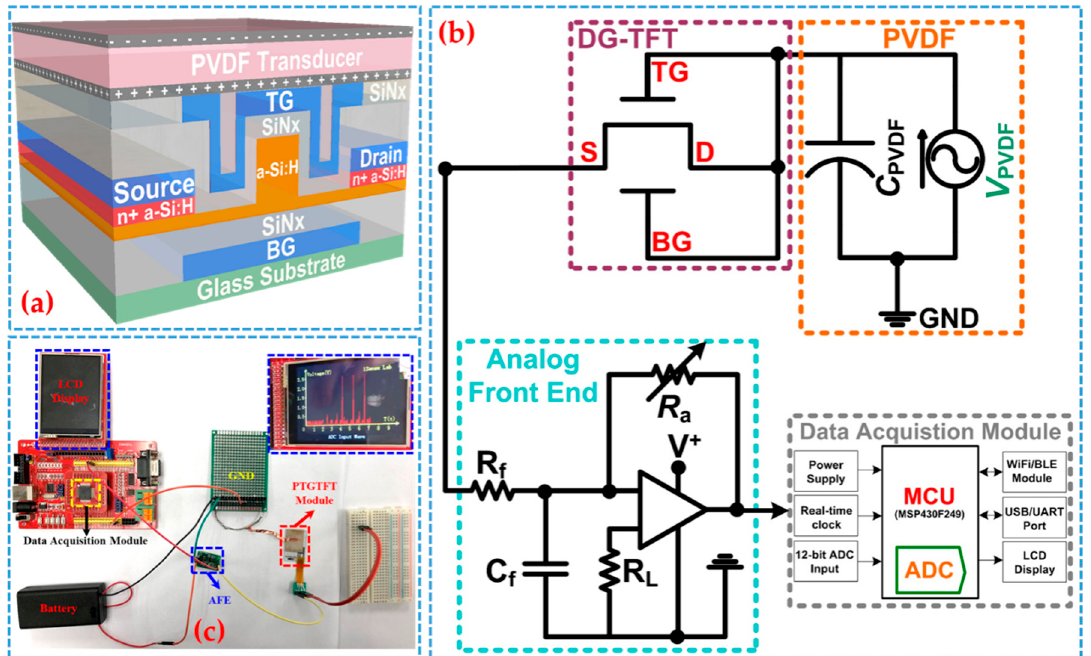
Figure 1. ( a ) Cross-sectional schematic illustration of a piezoelectric-transducer-gated thin-film transistor (PTGTFT) where a PVDF transducer is connected to a FIN-shaped a-Si:H piezoelectric transducer and a dual-gate thin-film transistor (DG-TFT); ( b ) equivalent circuit diagram of respiration monitoring sensor system composed of a PTGTFT, low-power analog front end (AFE) and conventional data acquisition module (MSP430F149); and ( c ) photo of the experimental setup for measuring the respiration rhythm signal by the proposed sensor system.